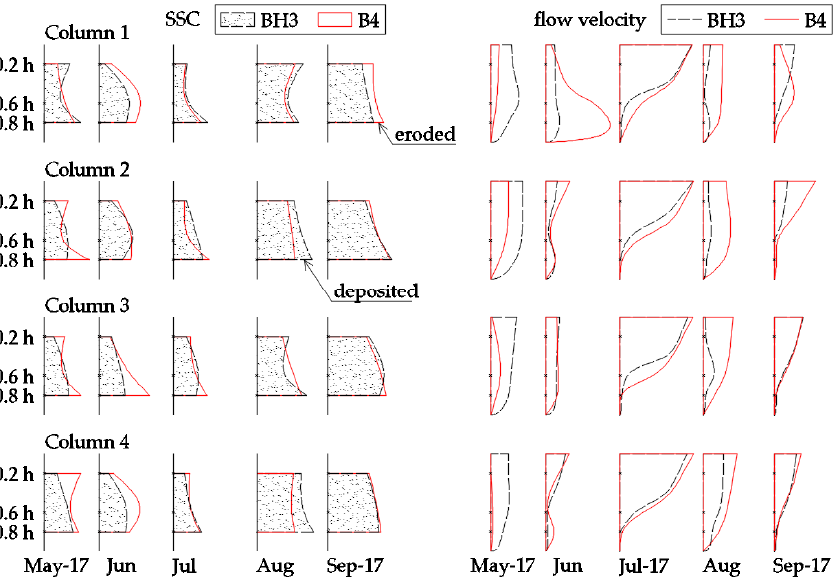
Figure 9. Sediment transport load and flow velocity in the BH3–B4 segment area.